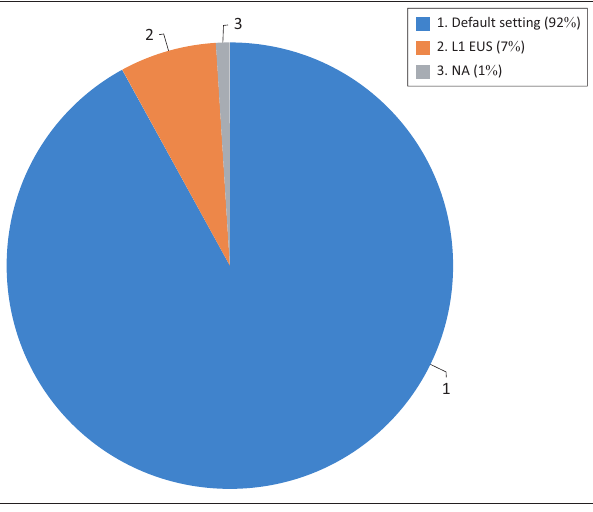
FIGURE 6: Point-of-care ultrasound scanning by level of point-of-care ultrasound